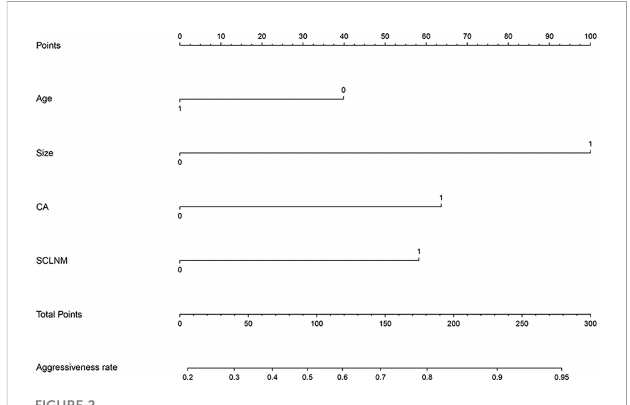
FIGURE 2 Nomogram to predict aggressiveness of papillary thyroid carcinoma (PTC). The nomogram incorporated patient age, tumor size, capsule abutment (CA), and suspected cervical lymph node metastasis